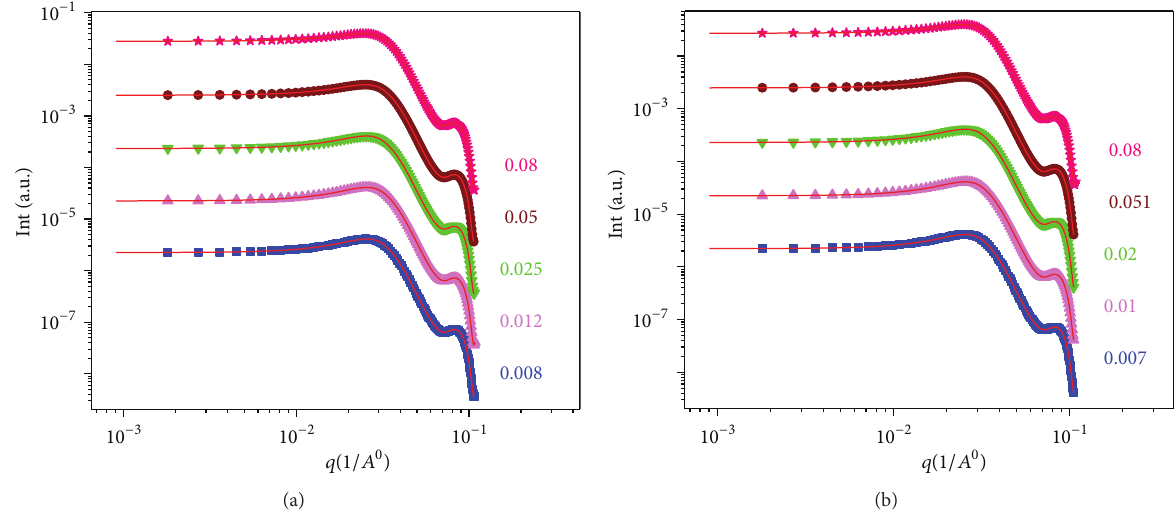
/𝑚 = 1.08 Dec C 12 E 5